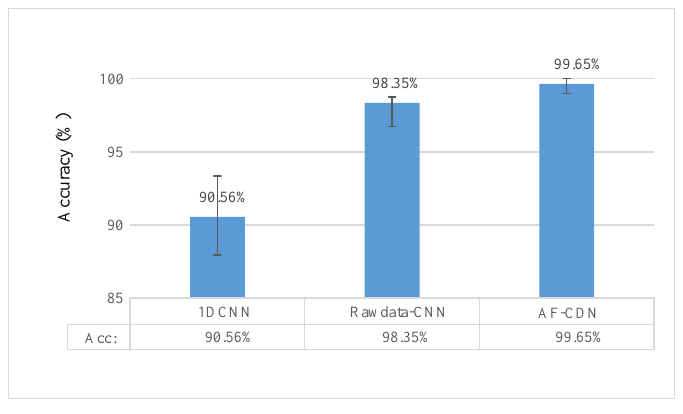
Figure 9. Results of the 10 experiments. Figure 10 uses T-SNE visualization technology to visually display the experimental classification results. In Figure 10a,c the visualization and error matrix of the AF-CDN are presented, respectively. In Figure 10b,d the visualization and error matrix of 1D-CNN algorithm are presented, respectively.